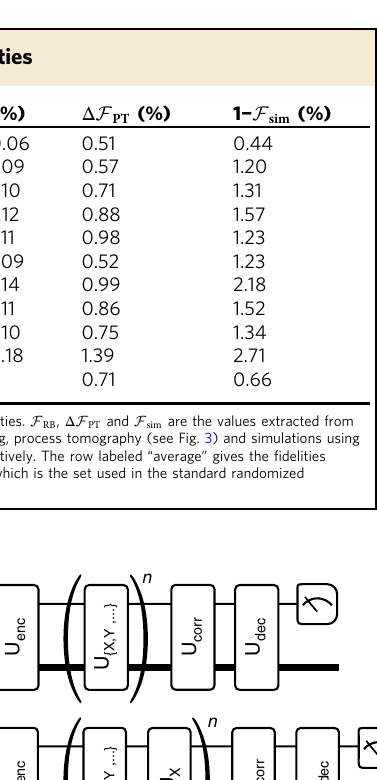
gate fi delities based on process tomography (Fig. 3) and Lindblad